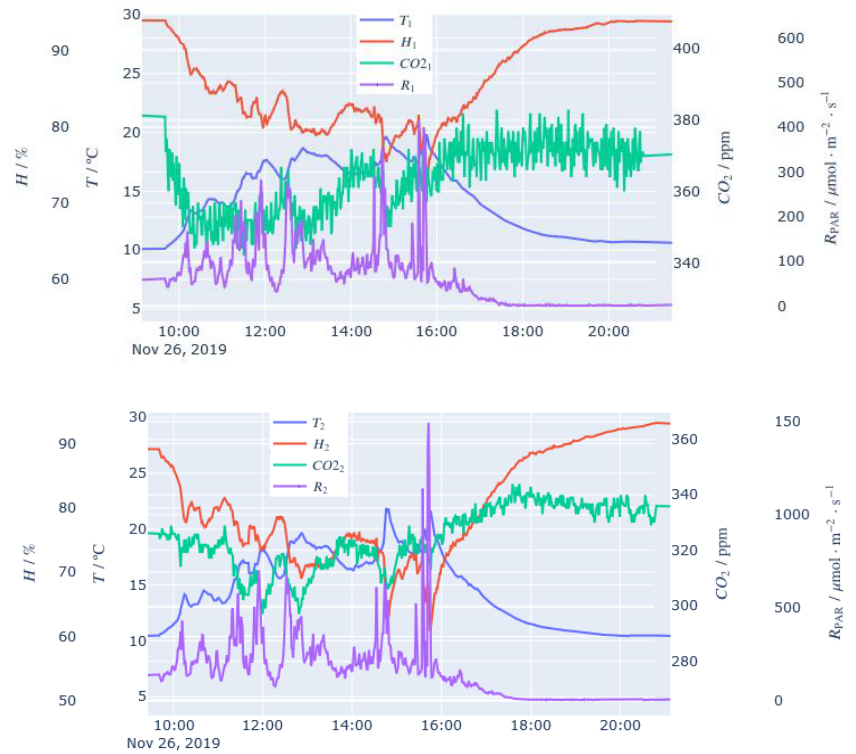
Figure 14. Relationship between temperature, relative humidity, CO 2 concentration and PAR radiation after planting (1: PV glass, 2: conventional glass).